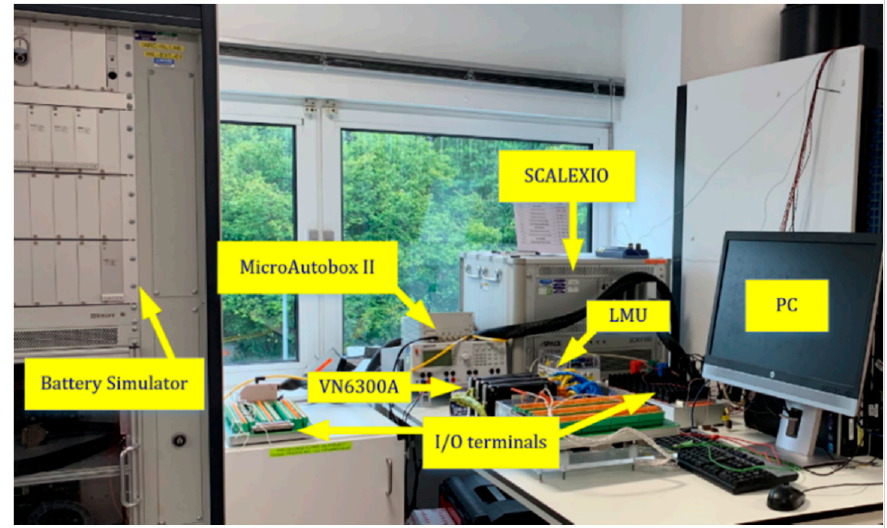
Figure 11. Actual HIL simulation platform